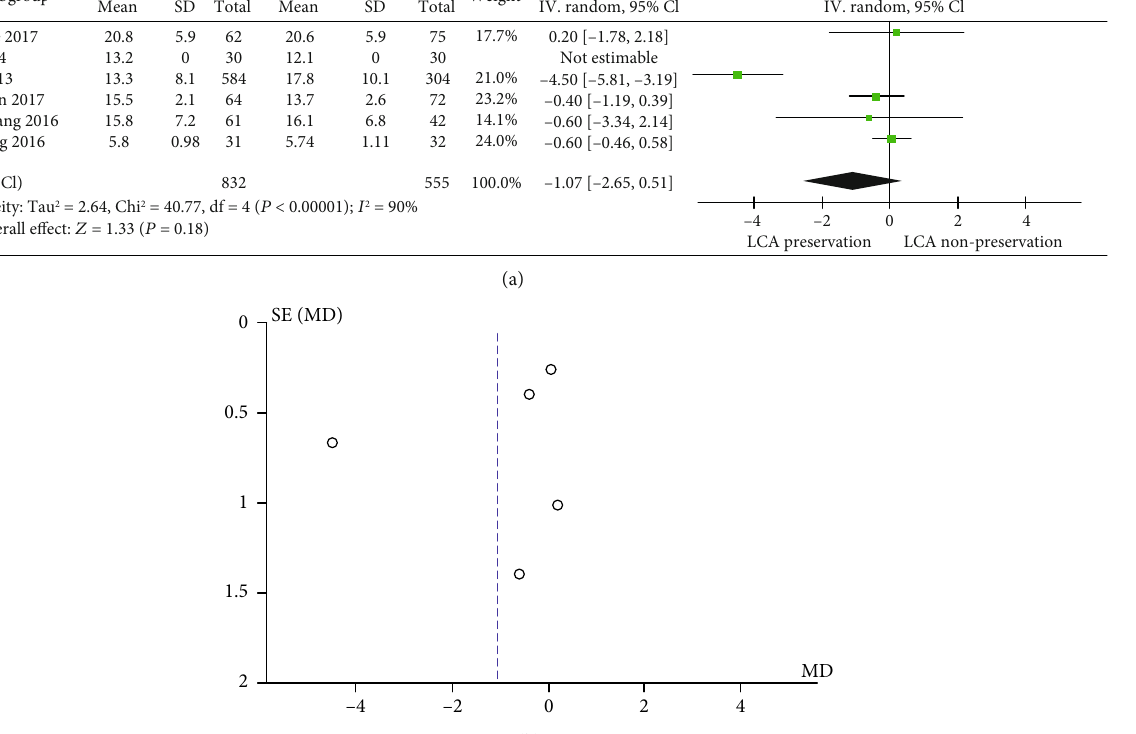
0.18)Total Heterogeneity: Tau 2 = 2.64, Chi 2 = 40.77, df = 4 ( P < 0.00001); I 2 = 90% Test for overall effect: Z = 1.33 ( P =